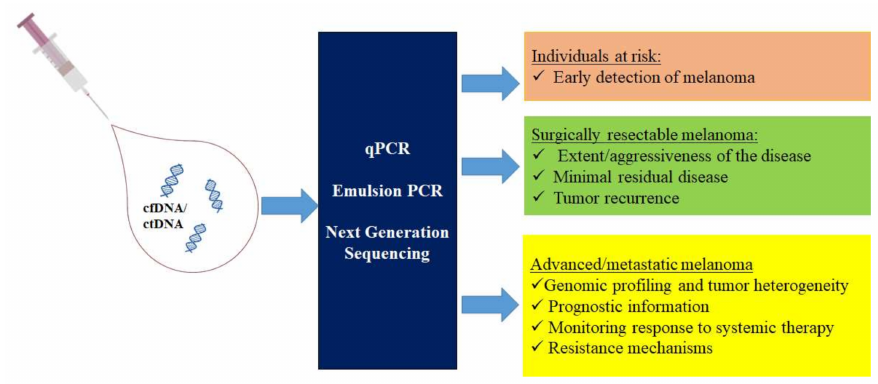
Figure 1. Applications of circulating tumor DNA (ctDNA) analysis in